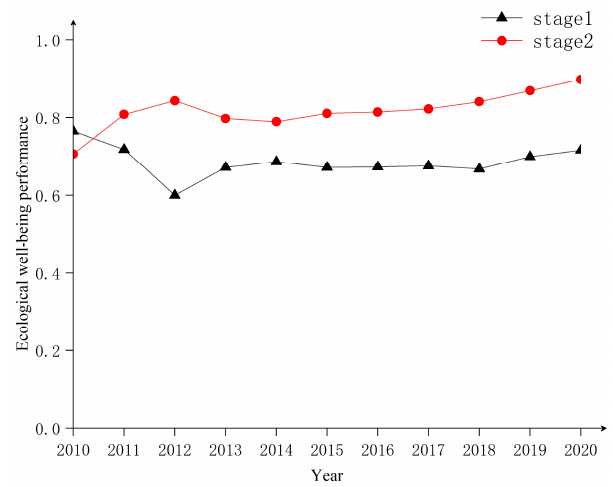
Figure 7. Two-stage EWP trends in the TGRA, 2010–2020.